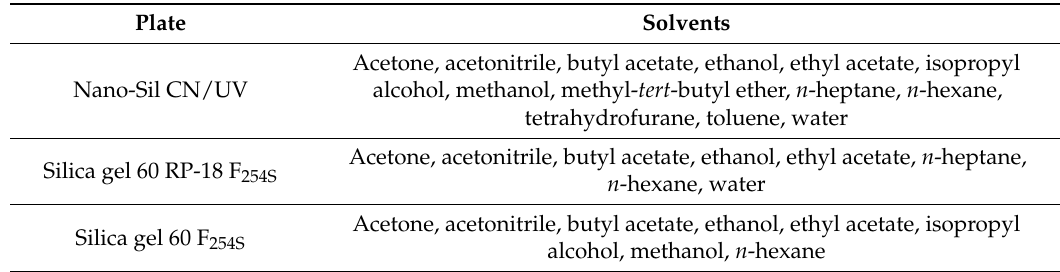
Table 1. Solvents used for the thin-layer chromatography (TLC) screening.